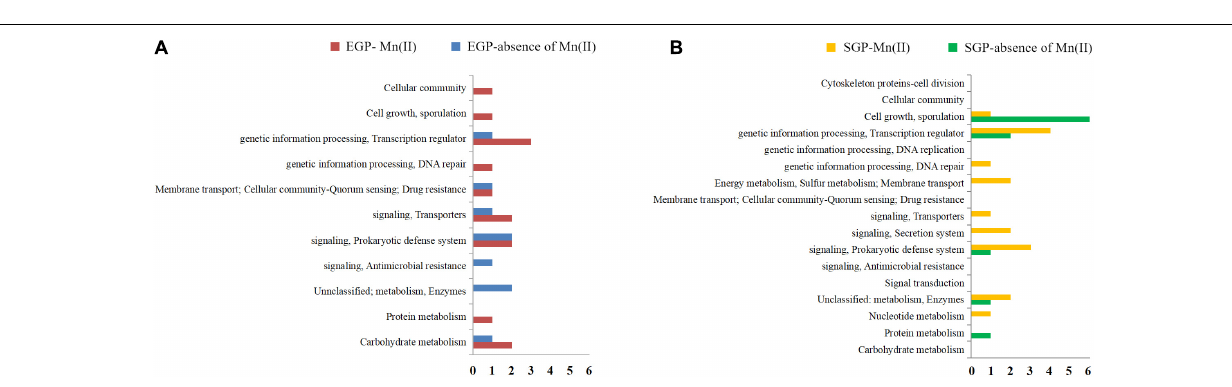
FIGURE 3 | Enriched pathways of genes affected by manganese exposure. (A) Enriched pathways of genes expressed during the exponential growth phase (EGP) of strain ST7 in the presence or absence of Mn(II). (B) Enriched pathways of genes expressed during stationary growth phase (SGP) of strain ST7 in the presence or absence of